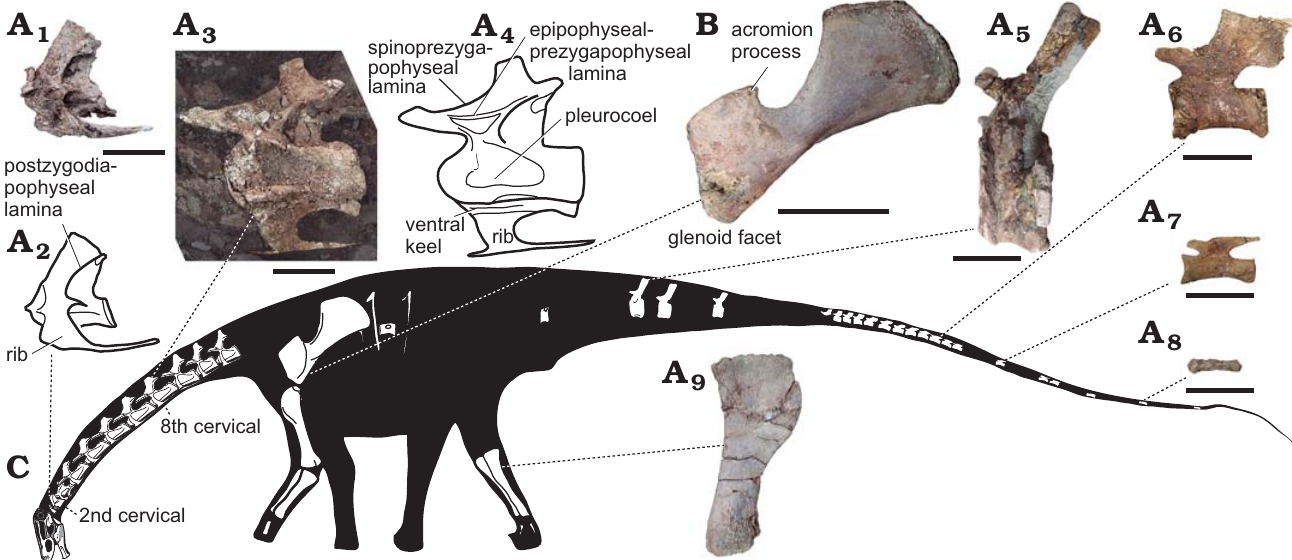
Fig. 2. Rebbachisaurid sauropod Lavocatisaurus agrioensis gen. et sp. nov. from Agrio del Medio (Argentina), Aptian–lower Albian. A . MOZ-Pv1232, axis in lateral view (A 1 , photograph; A 2 , drawing); eight cervical vertebrae in lateral view view (A 3 , photograph; A 4 , drawing, ); anterior caudal vertebra in lateral view (A 5 ); middle caudal vertebra in lateral view (A 6 ); posterior caudal vertebra in lateral view (A 7 ); posteriormost caudal vertebra in lateral view (A 8 ); left tibia in lateral view (A 9 ). B . MOZ-Pv 1255, left scapula from a juvenile specimen, in lateral view. C . Skeletal reconstruction based on the holotype and paratype specimens. Scale bars 10